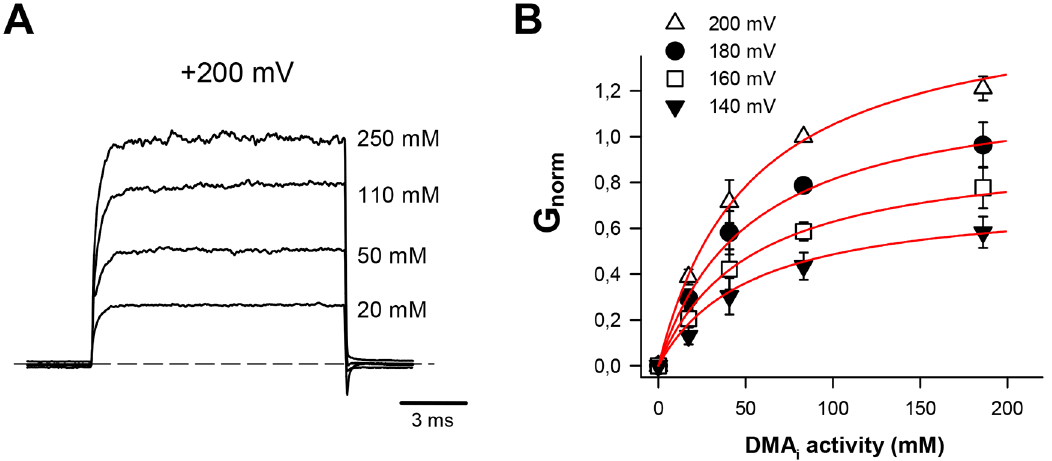
Fig 4. Currents activated by 1 mM cGMP in the presence of different voltage commands and amounts of DMA. (A) Representative currents observed in the presence of different amounts (indicated in the figure) of intracellular DMA (DMA i ) at +200 mV (holding potential of 0 mV). The dashed line indicates the zero-current level. Currents are normalized to the mean current observed in the presence of 110 mM DMA i and the solution filling the patch pipette contained 110 mM DMA. (B) Dependence of the cGMP-gated conductance on the ionic activity of DMA i at +140 (filled triangles), +160 (open squares), +180 (filled circles) and +200 mV (open triangle). Conductances are normalized to the conductance observed at +200 mV in the presence of 110 mM DMA i . Each point is the average obtained from at least three patches. These data have been fitted with the Eq (3) obtaining an apparent Kd = 52 mM. Data are presented as mean +/- SD (n =